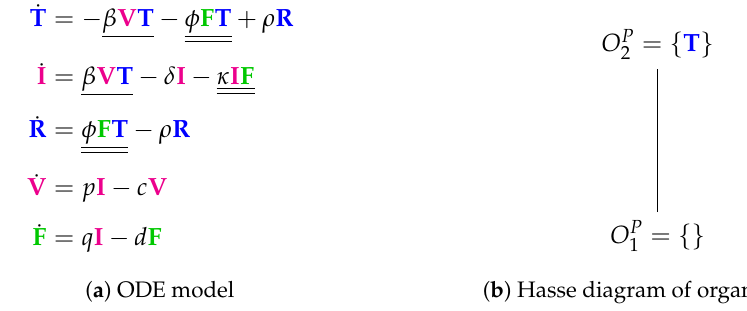
Figure 5. The Pawelek Model [23] with five variables: (uninfected) target cells ( T ), productively infected cells ( I ), uninfected cells refractory to infections ( R ), free viruses ( V ) and interferon ( F